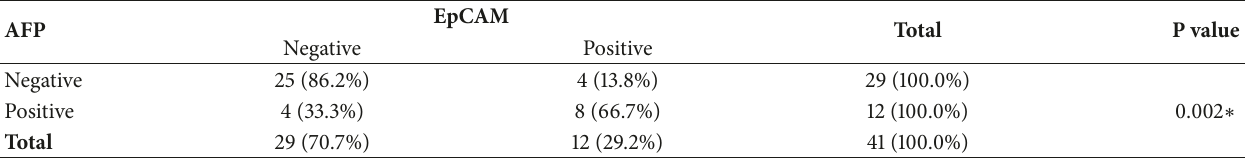
Table 2: Association between the immunohistochemical expressions of EpCAM and AFP in hepatocellular carcinoma.